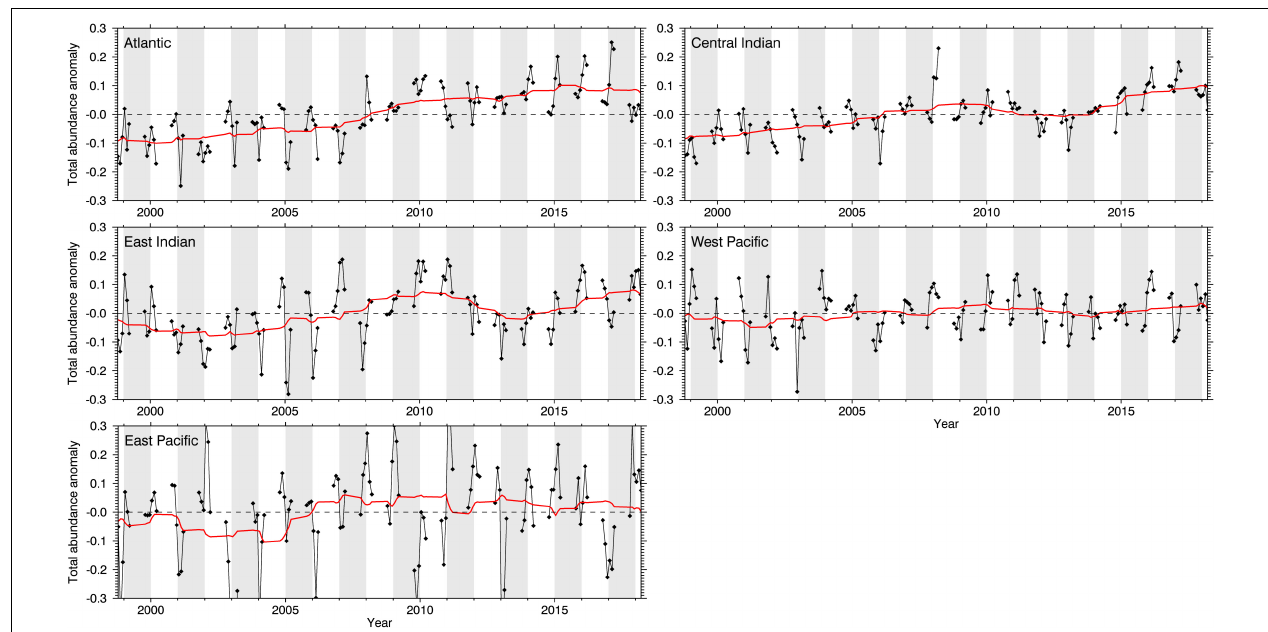
FIGURE 7 | Time series of change in environmental suitability for total zooplankton abundance, i.e., Euphausiidae, Copepoda (Calanoida and Oithona similis ), and pteropods, from the combined Boosted Regression Tree model of Pinkerton et al. (2020) for Southern Ocean MEASO Zones. Time Series change for each individual MEASO Area are given in Supplementary Figure 3 . The environmental suitability anomaly (difference from the monthly climatological value) is shown for each month over period 1998–2018. Gray shading indicates calendar years. Black points and lines are monthly anomalies (differences from long-term monthly means). Red lines are smoothed changes (4-year running